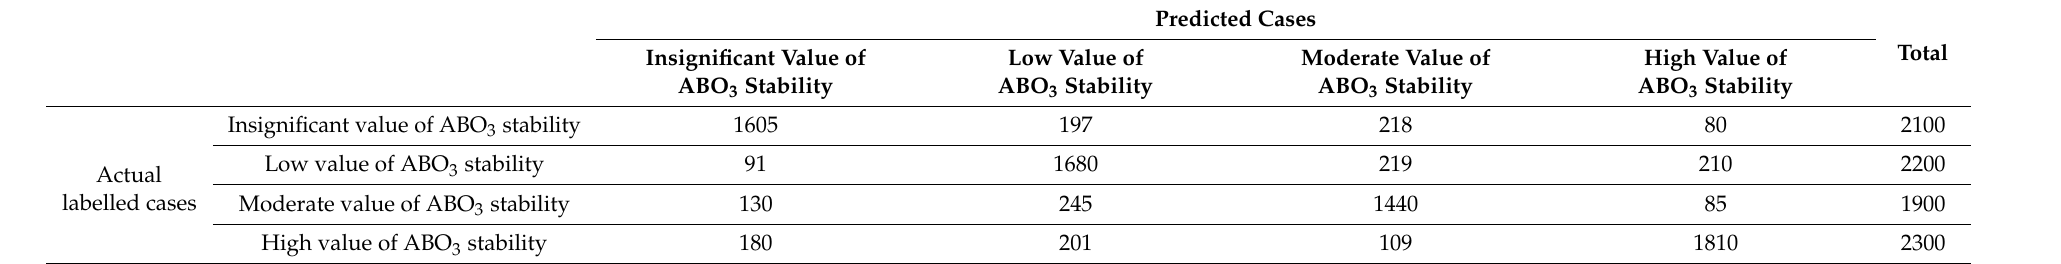
Table 8. Confusion matrices for value of ABO 3 stability without transfer learning.